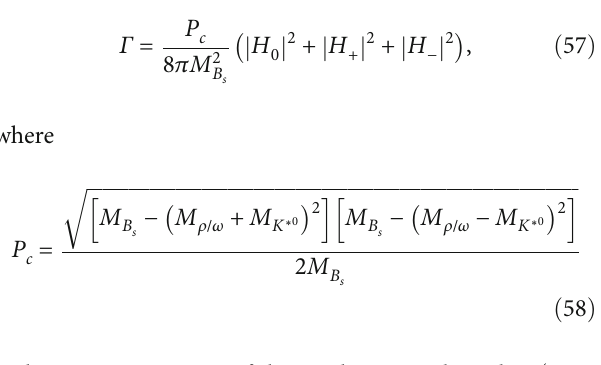
(cid:1) ⟶ ρ 0 ð ω Þ K ∗ 0 B 0 s